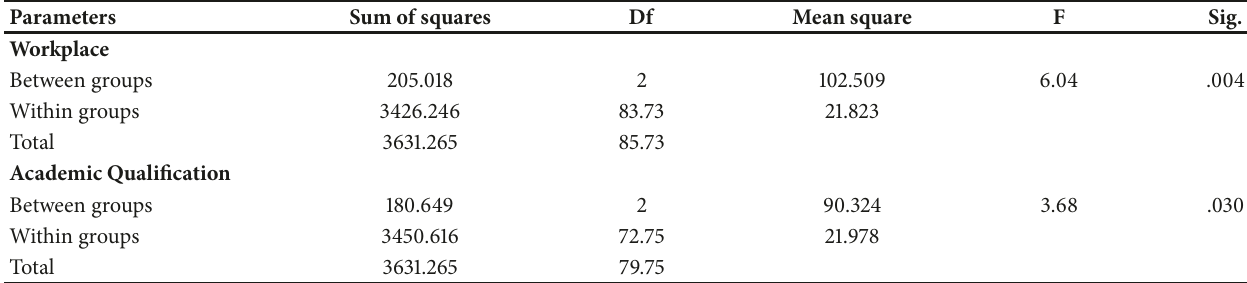
Table 6: Comparison of knowledge scores in terms of workplace and academic qualification, Welch’s Anova ( N =